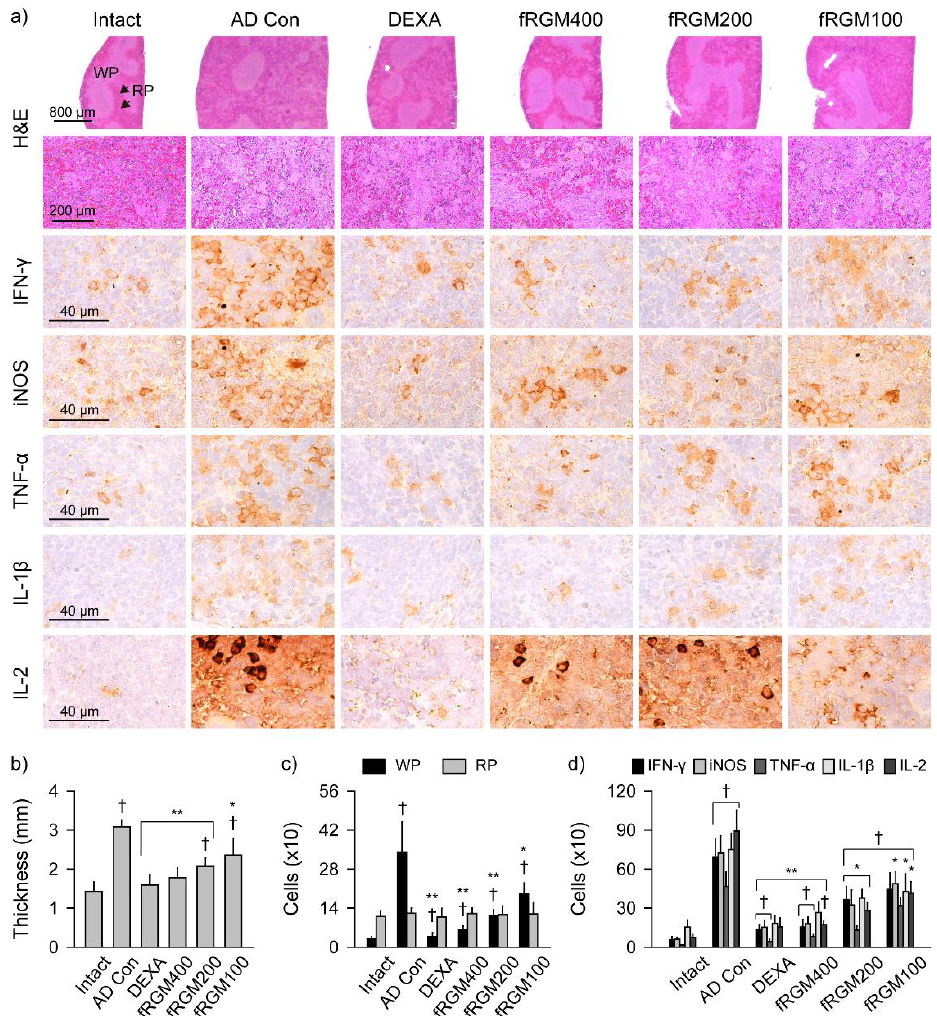
Figure 6. Histopathological changes in the spleen of the AD-like model. ( a ) Representative images in H&E stain and immunostains for IFN- γ, iNOS -2, TNF- α, IL - 1β , and IL-2 in the spleen. In the H&E stains, the upper showed white pulp (WP) and red pulp (RP, arrows), and the lower was the high-magnified parenchyma. ( b ) The splenic thickness in the central region (mm). ( c ) Number of WP and RP cells in parenchyma (cells/mm 2 ). ( d ) Immunoreactive cells in the splenic parenchyma (×10 cells/mm 2 ). Values are represented as means ± SDs. †: p < 0.05 vs. the Intact group; **: p < 0.01 and *: p < 0.05 vs. AD Con.